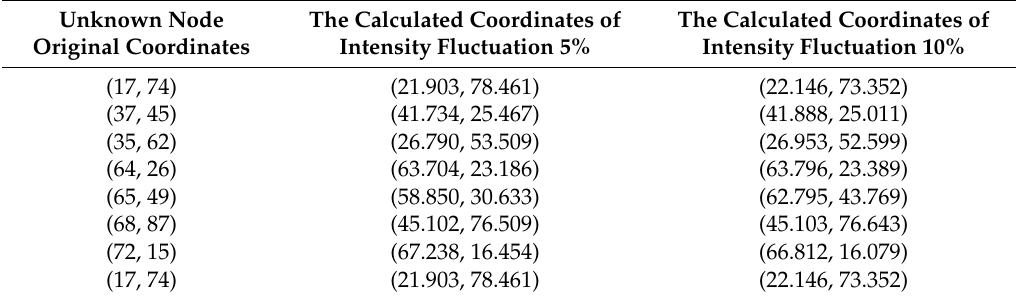
Table 5. Localization results ( n = 16).